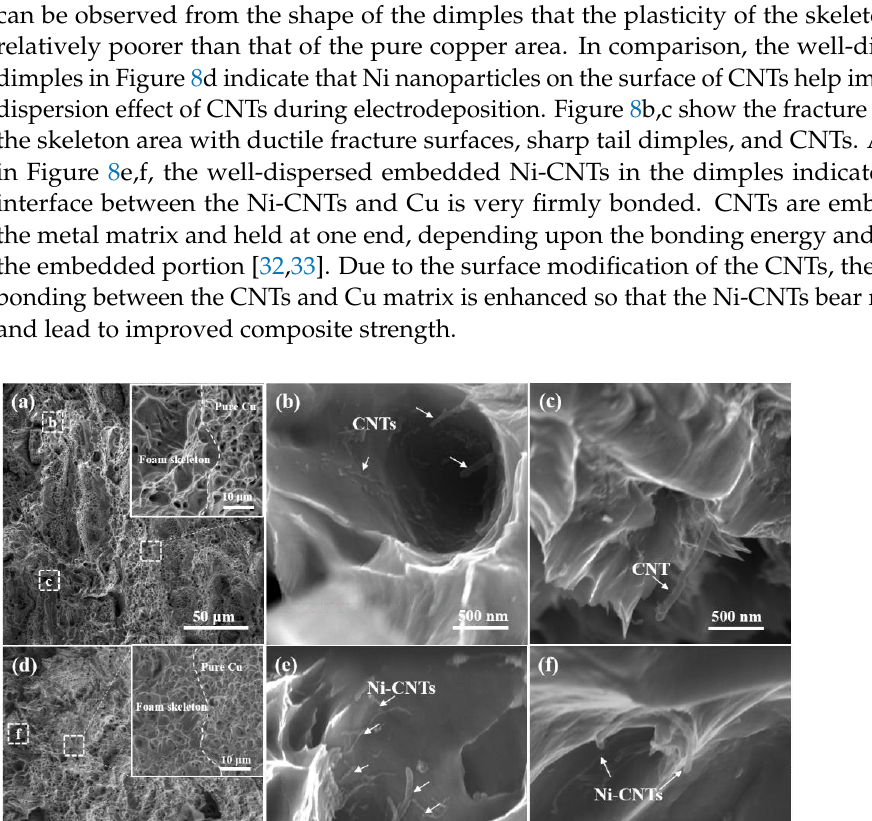
Figure 7. ( a , b ) The tensile stress – strain curves of pure Cu and composites.